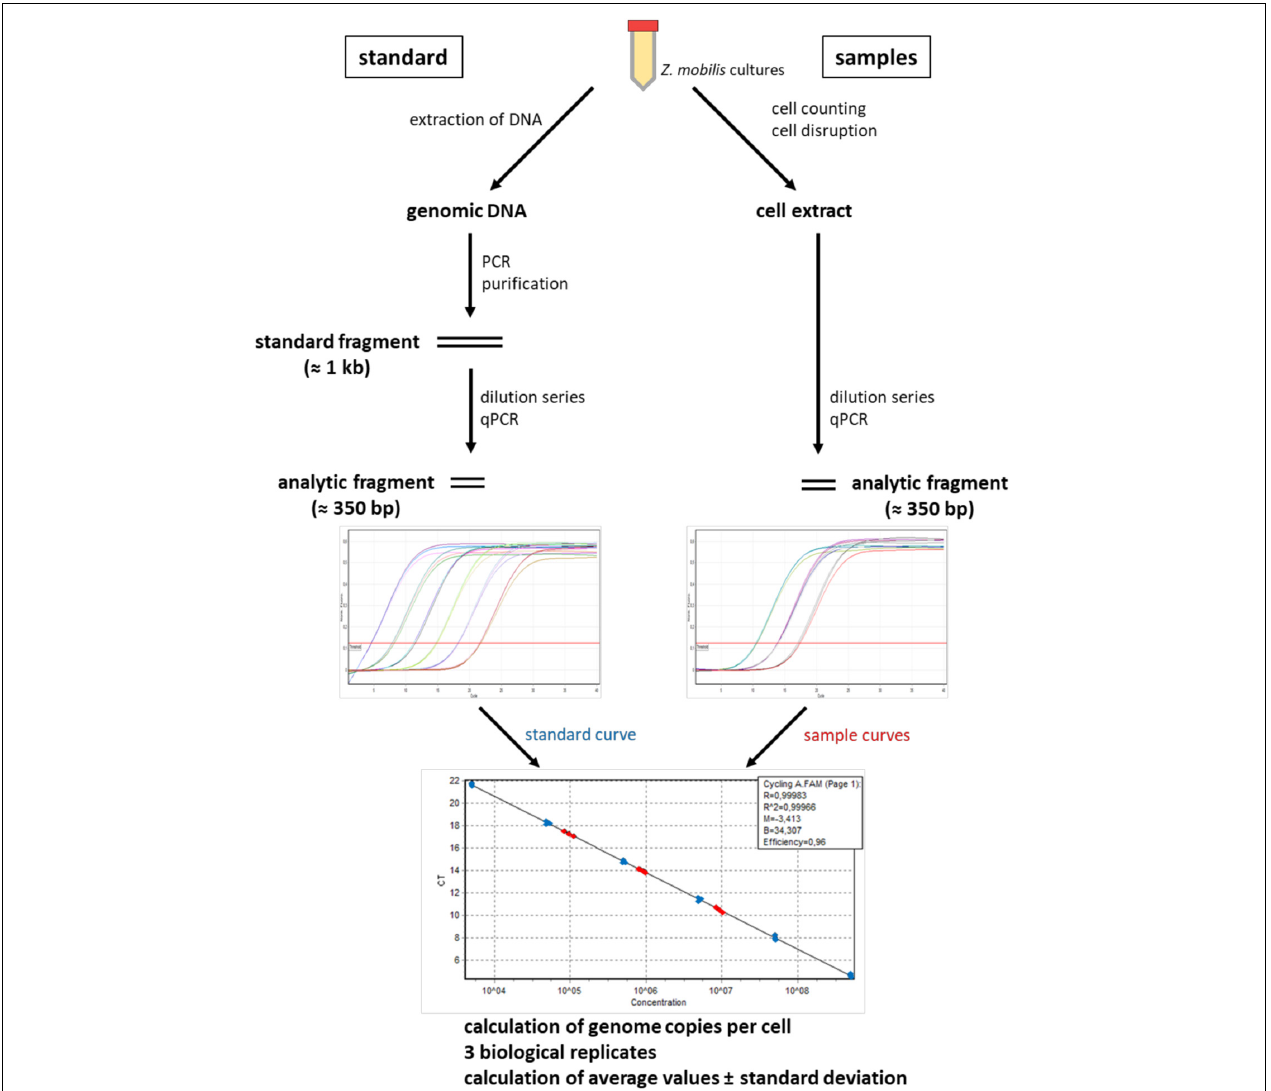
FIGURE 1 | An overview of qPCR method to quantify genomic copy numbers in Z. mobilis